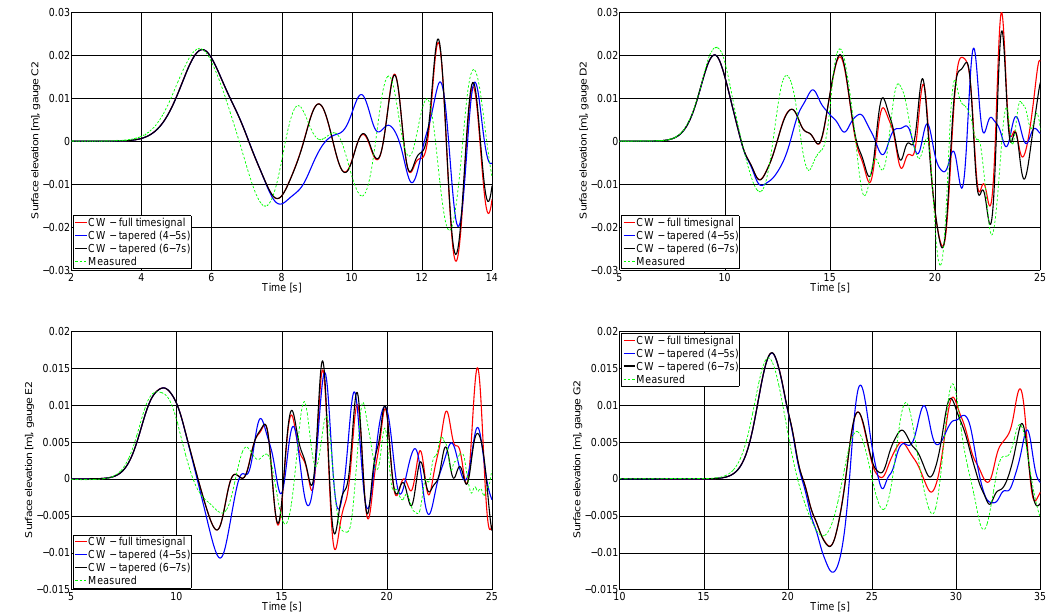
Figure 5. Comparison of the simulated surface elevations offshore using Coulwave at central gauges along the C, D, E, and G bridges. The effect of tapering the input signal is demonstrated.